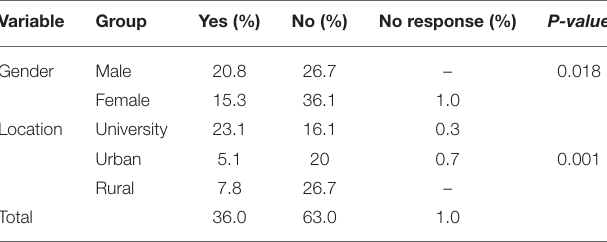
TABLE 2 | Consumer awareness on cultured beef production in Eastern Cape Province of South Africa ( n =